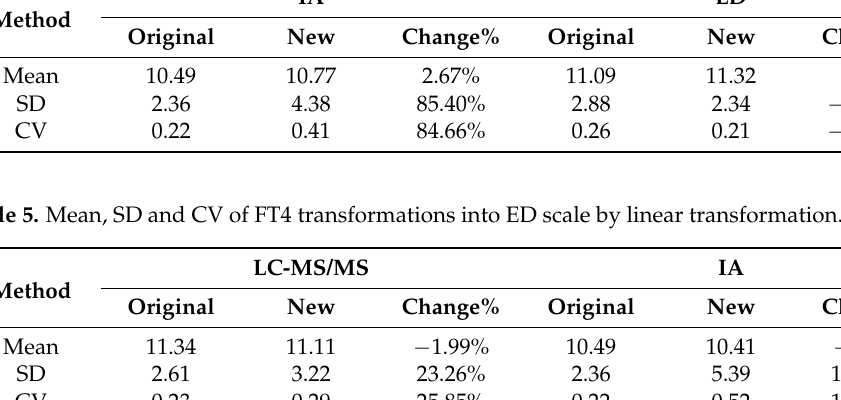
Figure 2. ( A , B top row). Comparison FT4 values and their transformations in the reference interval scale (9, 16) of IA, with respect to LC-MS/MS and ED, using linear transformation. ( C , D middle row). Comparison FT4 values and their transformations in the reference interval scale (8, 21) of LC-MS/MS, with respect to IA and ED respectively, using linear transformation. ( E , F bottom row). Comparison FT4 values and their transformations in the reference interval scale (7, 23) of ED, with respect to LC-MS/MS and IA, using linear transformation. Blue represents original FT4 result, orange represents the transformed scale (from the blue line) to the scale of interest, while green represents the original untransformed results in the scale of interest.